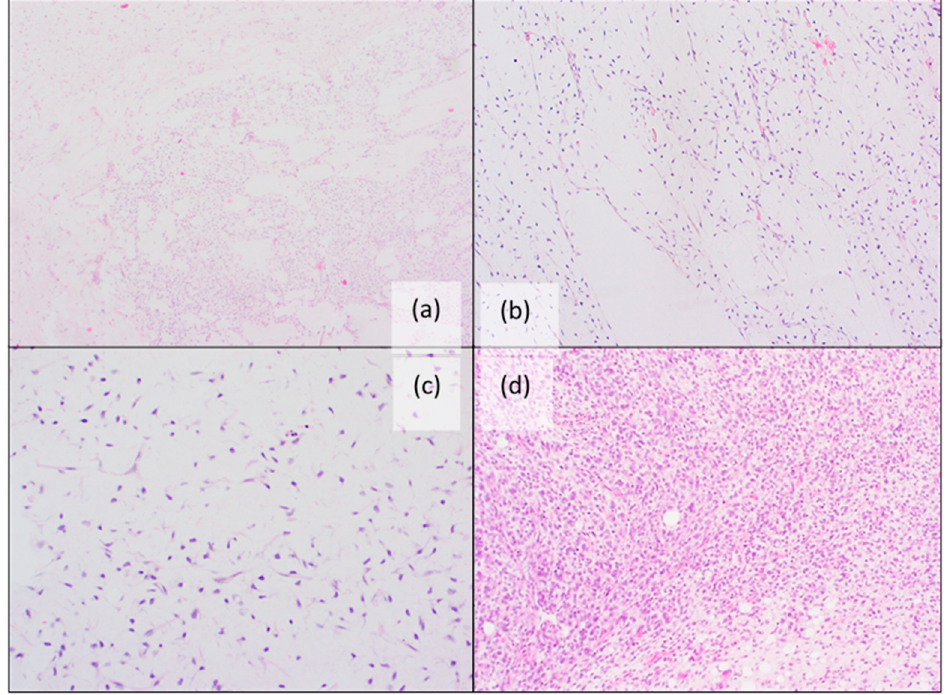
Figure 3. Histopathological features of myxoid liposarcoma: ( a ) Characteristic alveolar and edema- like growth pattern (H&E staining); ( b , c ) Myxoid stroma with arborizing “chicken-wire” vessels and lipoblasts (H&E staining); ( d ) High-grade MLPS with more than 5% cellular overlap, diminished myxoid matrix, less apparent capillary vasculature, a higher nuclear grade and increased mitotic activity (H&E staining).